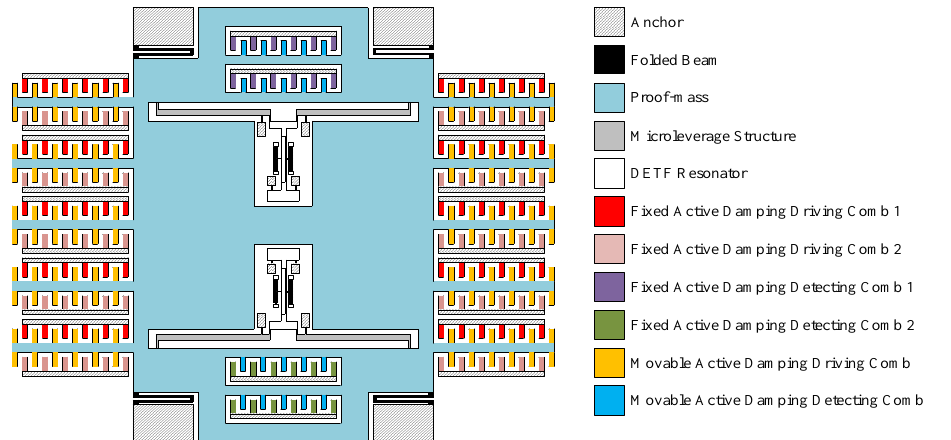
Figure 3. Overall structure of a micromachined silicon resonant accelerometer based on the closed- loop control of electrostatic active damping. Table 1. Structural dimensions associated with the electrostatic active damping